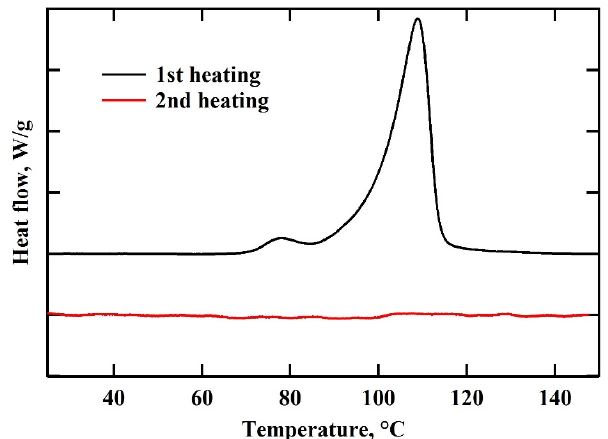
Figure 3. DSC curves: first (black) and second (red) heating traces of bulk C8AzoPyr after long annealing at room temperature.